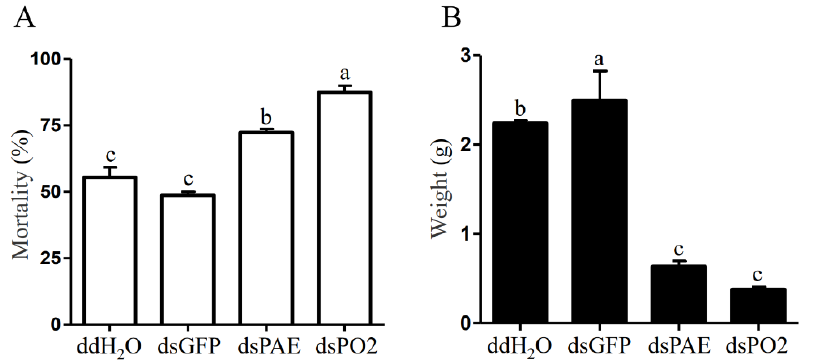
Figure 4. Comparison of mortality and weight of surviving larvae injected with different dsRNAs. ( A ) Mortality of larvae, ( B ) weight of surviving larvae. Bars with the same letter are not significant, and different letters indicate a significant difference from each other at p < 0.05 based on Tukey’s test.